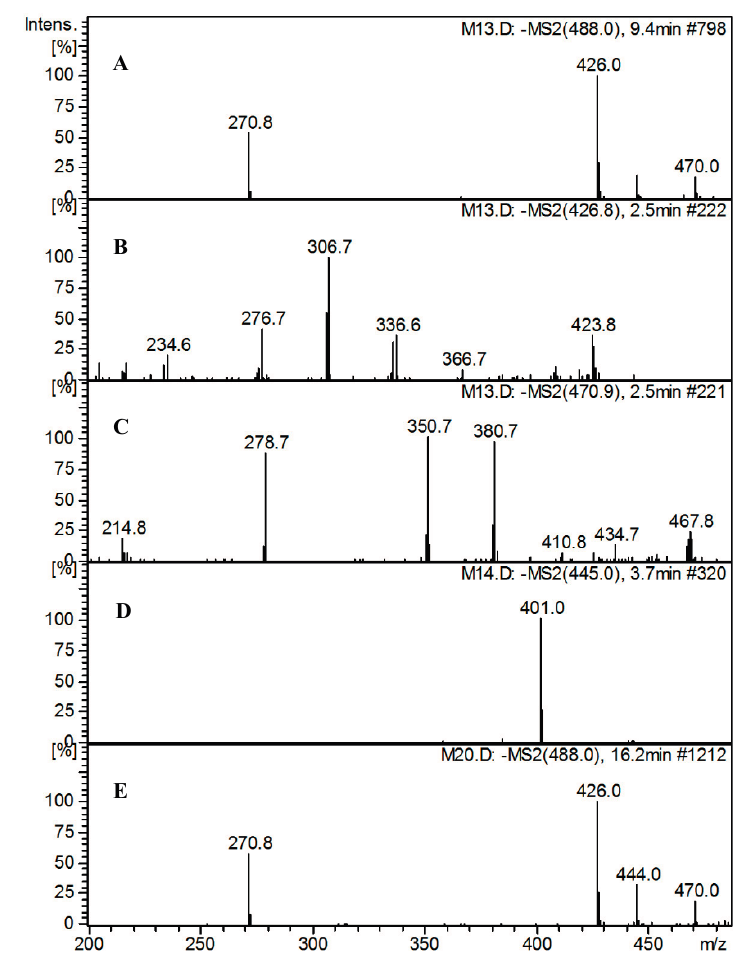
Figure 4. Mass spectra of compound MYA-3 and its detected metabolites. ( A ) MS2 spectra of compound MYA-3; ( B ) MS2 spectra of T1; ( C ) MS2 spectra of T2; ( D ) MS2 spectra of metabolite T3; ( E ) MS2 spectra of metabolite